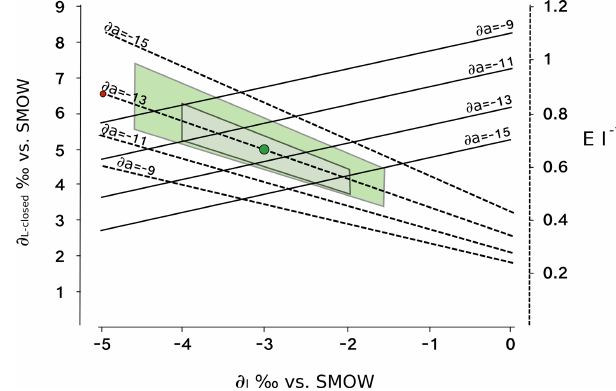
Figure 8. Final δ 18 O uncertainties in δ L − closed and E/I calculated by taking ± 1 σ for δa and δ I . The green dot represents the E/I and δ L − closed average value, and the green polygon is the associ- ated uncertainty. δa is the mean annual value (Jasechko et al., 2013) weighted by evaporation flux (DREM data) and δ I is the Chari– Logone rivers’ mean annual value weighted by flow rate (Bouchez et al., 2016). The red point represents the δ L − closed and E/I val- ues for δ I taken at the intersection between Iro Lake’s LEL and the GMWL. The grey polygon represents the E/I uncertainties by tak- ing h ±